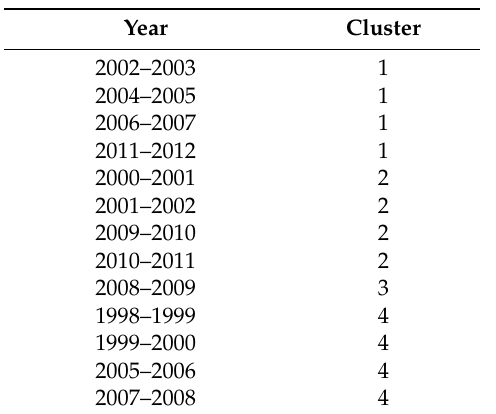
Table 2. Years included in each rainfall sub-regime (Cl1 to Cl4) detected on the rain time series, by spectral clustering method, in the northeastern region of the AB.